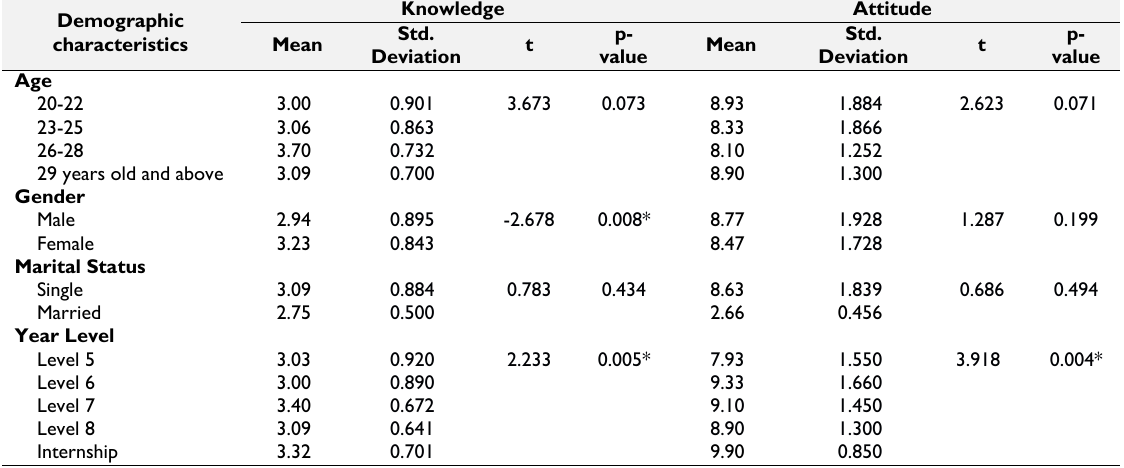
Table 2 Differences between demographic characteristics and knowledge and attitudes of the nursing students toward COVID-19 vaccine Demographic